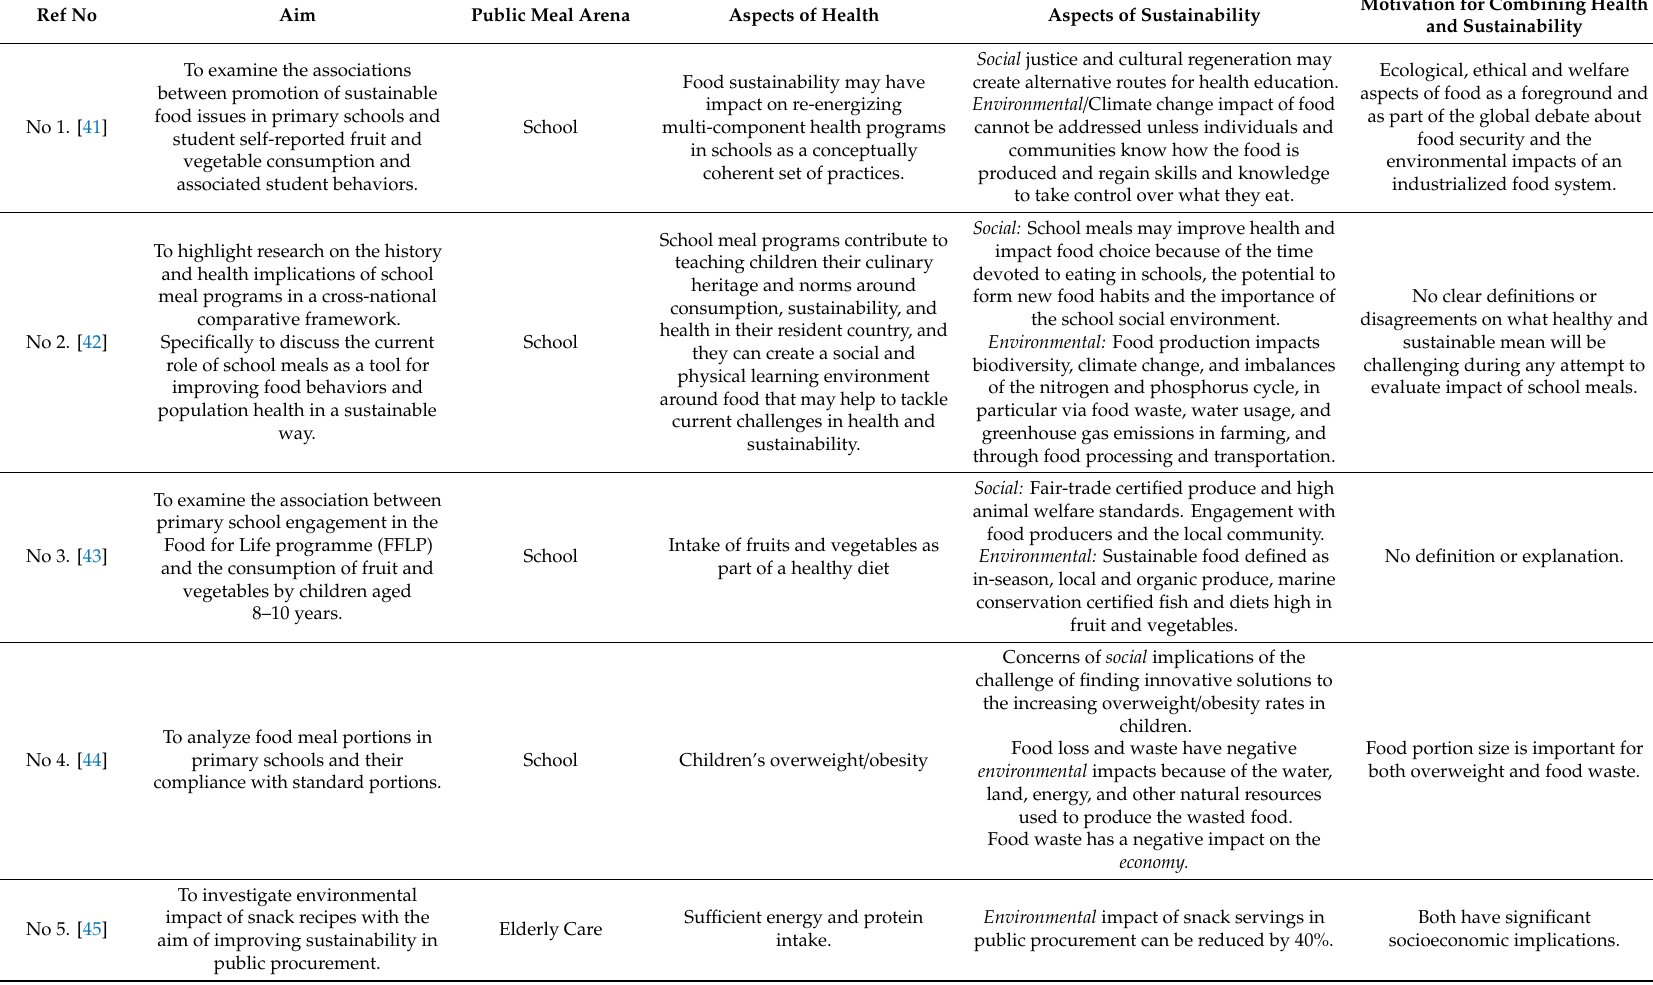
Table 4. Main content of the included